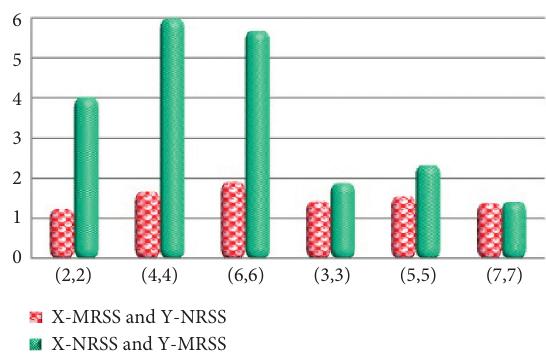
Figure 5: RE of SSR estimates at R � 0.5556.